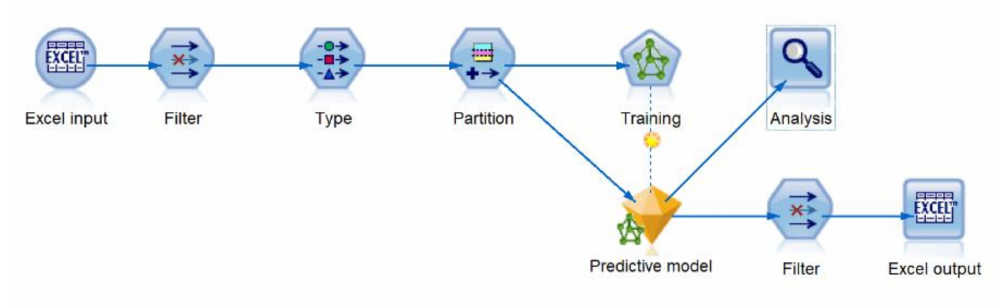
Figure 6. Training and validation stream developed in IBM SPPSS modeler.